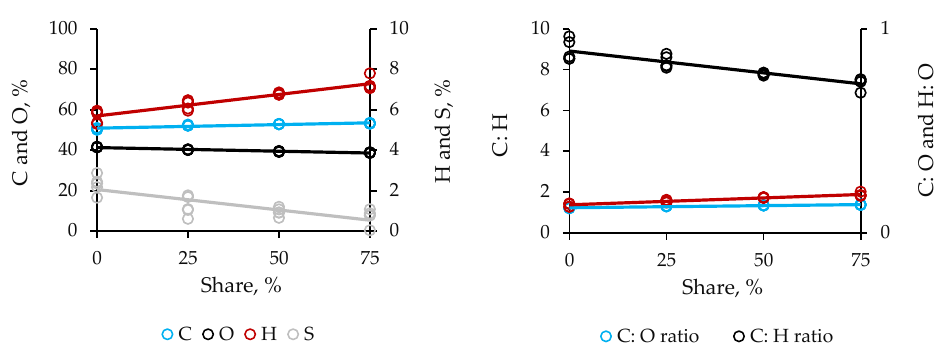
Figure 5. Effect of share of residual biomass from distillation of cellulosic bioethanol in the blend with sugarcane bagasse on the elemental properties of composite pellets. The steeper the line is, the larger the probability of the factor to becoming the cause of significant variability is, as it gains in linearity.